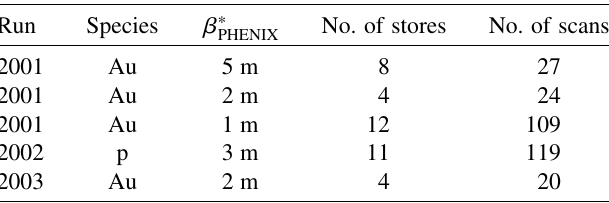
TABLE II. Synopsis of channeling data.